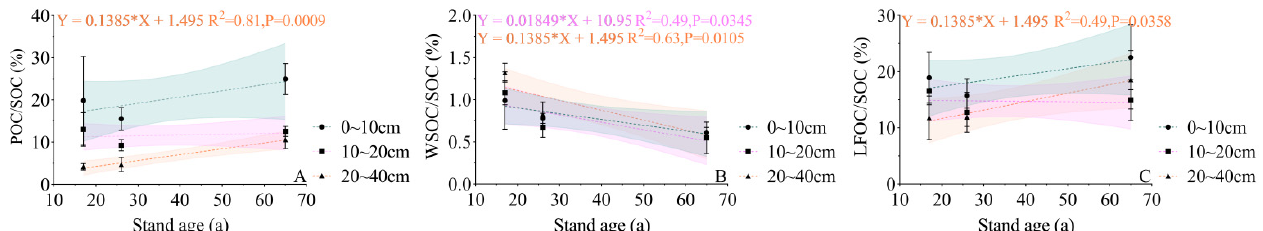
Figure 3. Ratio of soil labile organic carbon fractions and organic carbon in differently aged Quercus acutissima forests. Ratio of particulate organic carbon and organic carbon (POC/SOC, A); Ratio of soil water-soluble organic carbon and organic carbon (WSOC/SOC, B); Ratio of light fraction organic carbon and organic carbon (LFOC/SOC, C) (mean ± SD, n = 3).